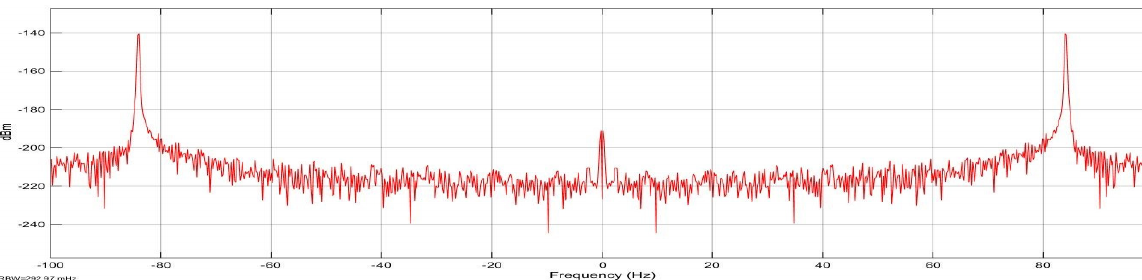
Fig. 6: Frequency Response of the Lateral Acceleration when Vehicle speed = 10m/s and Conicity of Wheel = 0.1